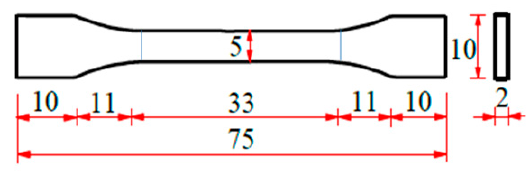
Figure 1. Schematic of the specimen (unit: mm) [3].